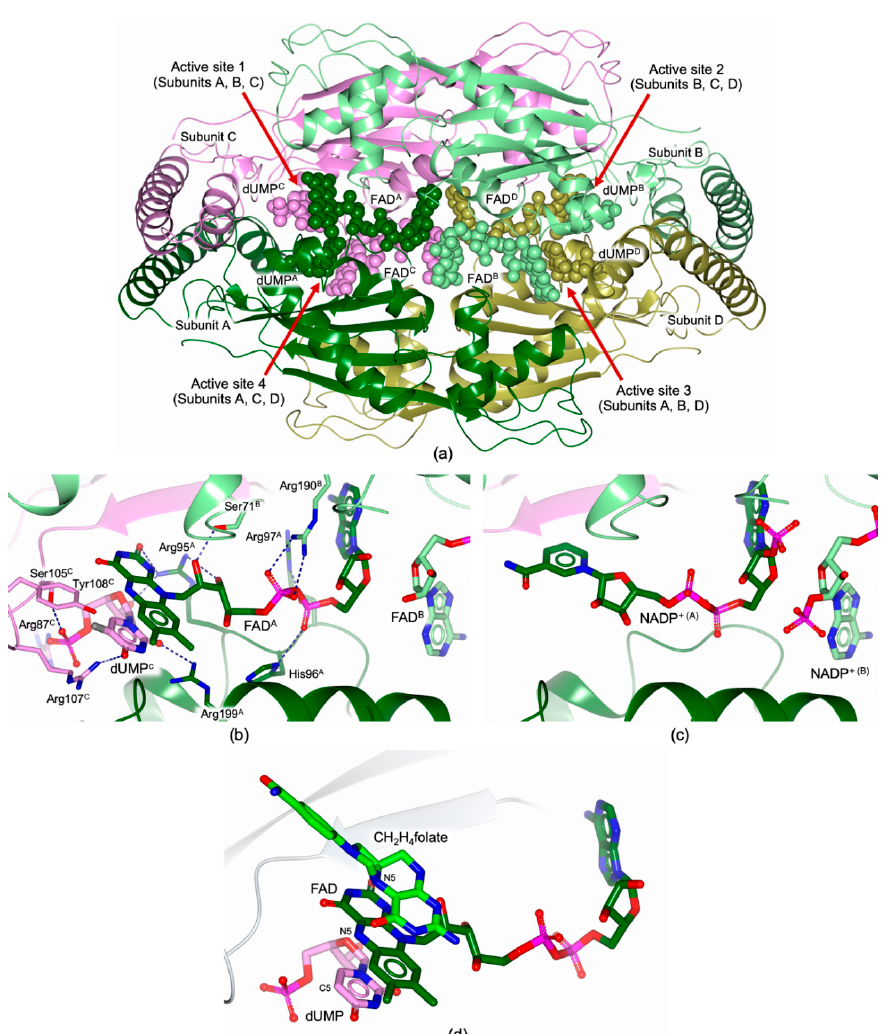
Figure 5. ( a ) Cartoon representation of the FDTS homotetramer ( Mtb FDTS; Subunit A is colored dark green, B light green, C pink, and D gold; PDB id 3GWC [44]). Subunits contributing to each active site